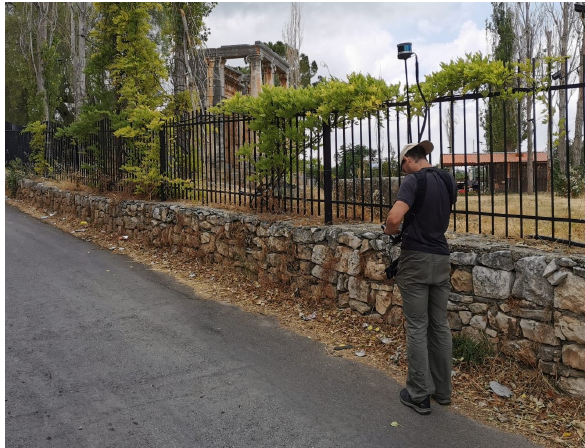
Figure 5. Surveyor performing the mapping of the Bziza temple and its surroundings with the HERON Lite